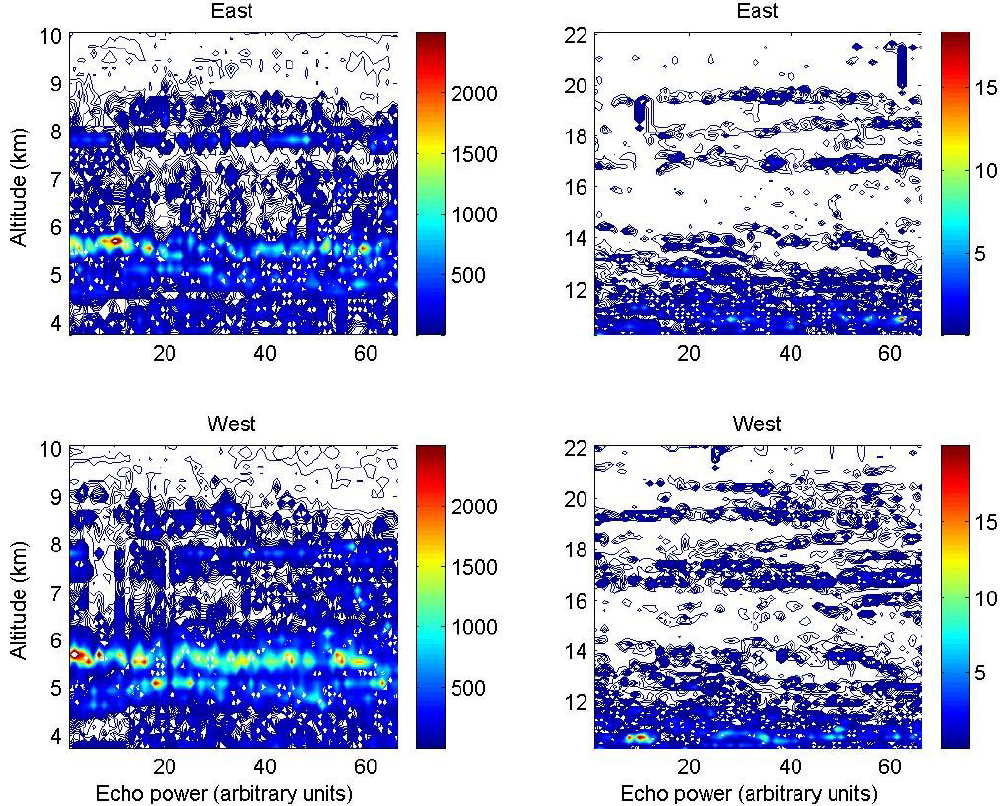
Fig. 9. Contours of echo power for radial velocities (12 May 2004) in two altitude ranges 4–10km (left panel) and 10–20km (right panel). Corresponding contour intervals are 5ms − 1 and 0.5ms − 1